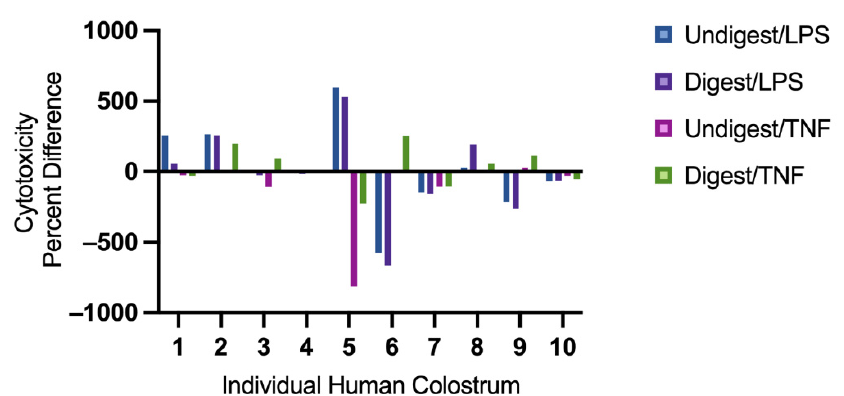
Figure 4. Cytotoxicity percent difference in individual digested and undigested human colostrum in response to lipopolysaccharides or tumor necrosis factor. Cytotoxicity percent difference was calculated to identify change of percent cytotoxicity in Caco2BBe cells following treatment of digested or undigested colostrum samples against their unpretreated controls. It was calculated as: (Pretreated percent cytotoxicity − Unpretreated percent cytotoxicity)/Unpretreated percent cytotoxicity × 100. From left to right: human colostrum sample 1–10. LPS = lipopolysaccharides; TNF = tumor necrosis factor.